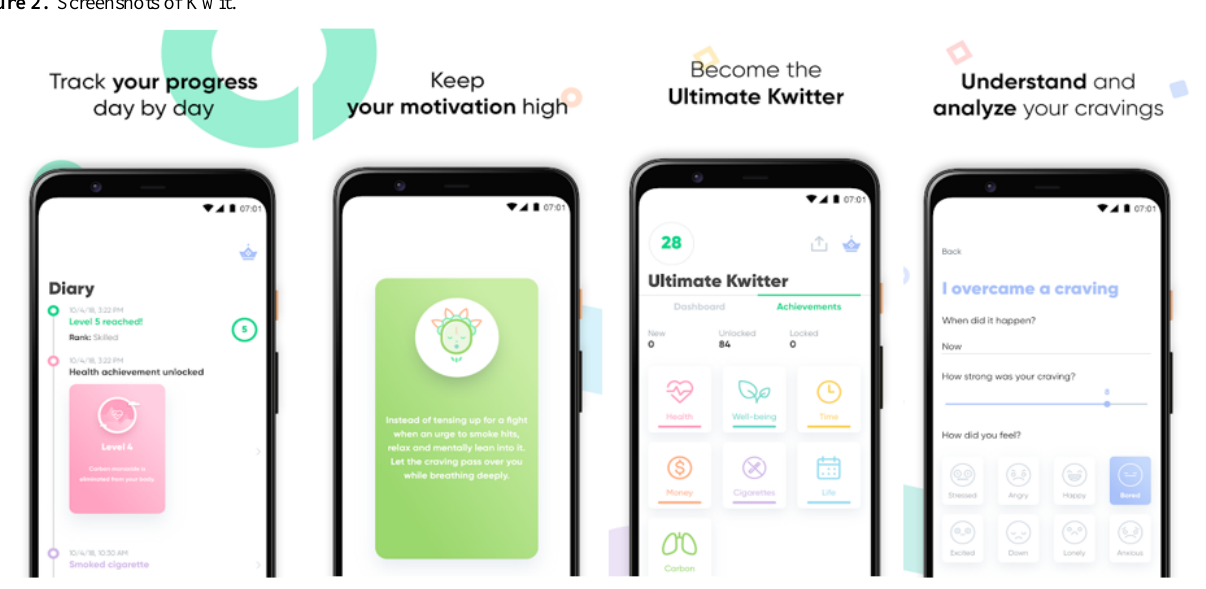
Figure 2. Screenshots of